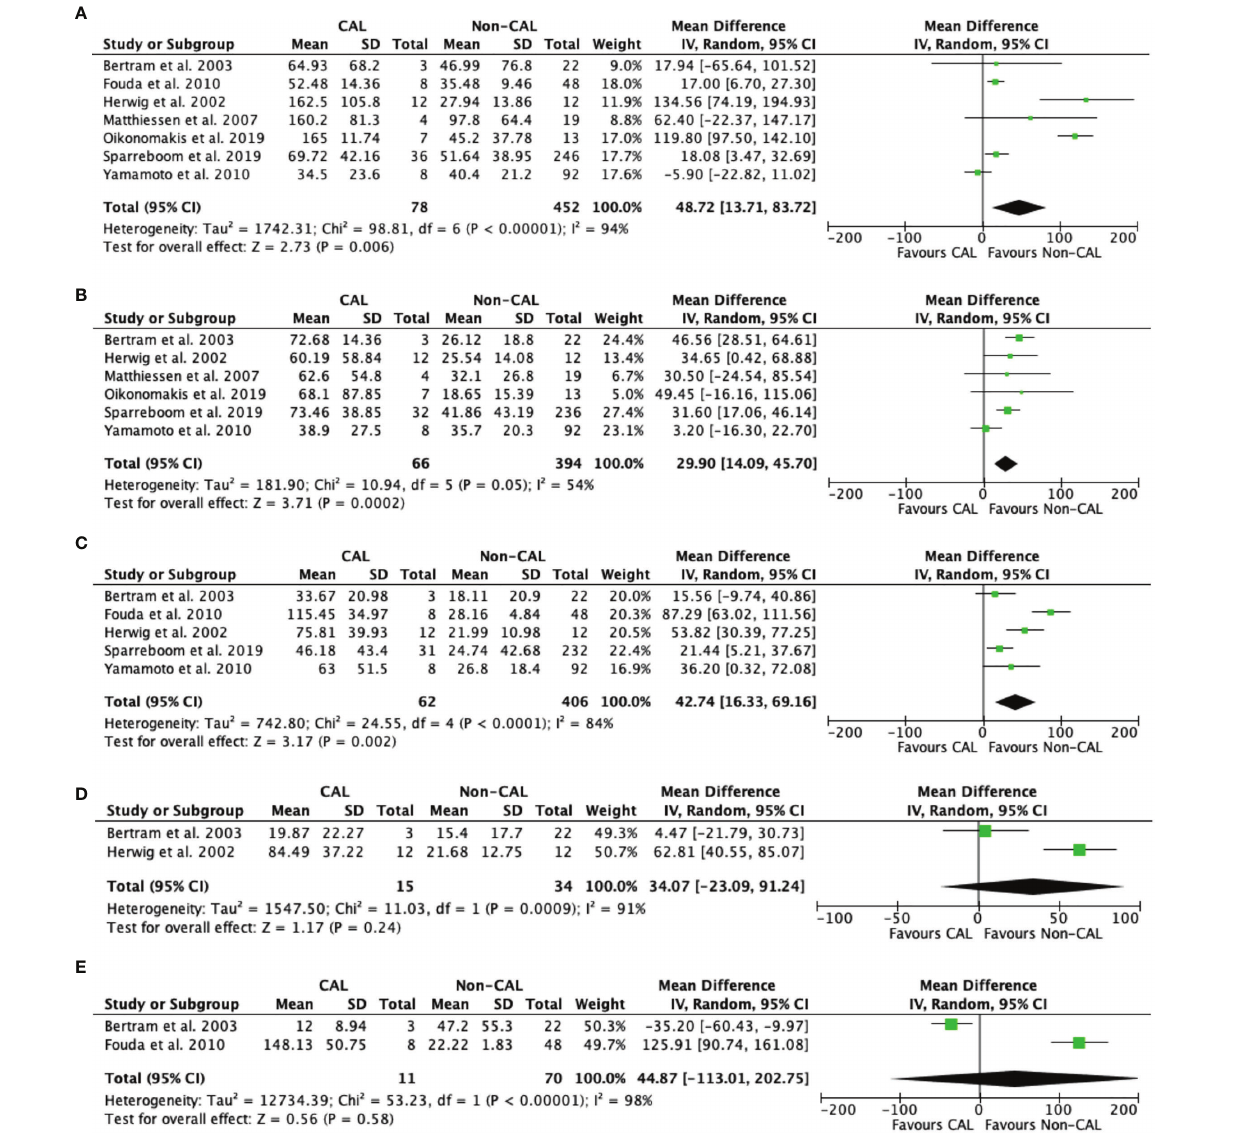
FIGURE 4 | Forest plot of peritoneal levels of IL-6 (ng/mL) on patients with CAL and non-CAL patients each postoperative days (POD) 1 (A) , 2 (B) , 3 (C) , 4 (D) and 5 (E)